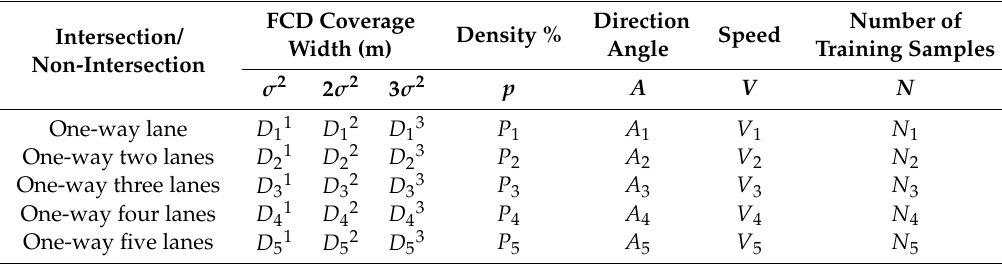
Table 2. Basic classifier based on floating car data (FCD) probability density for lane number detection in the experiential area.